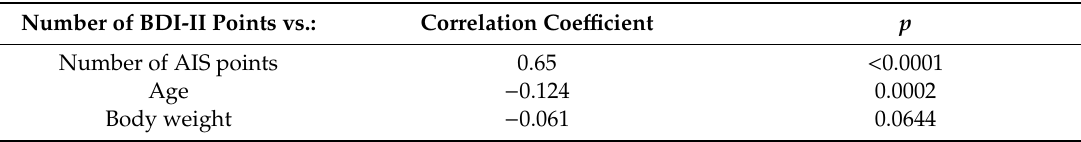
Table 5. Correlation between BDI-II and AIS scores and body weight and age of the respondents by means of Spearman’s rank